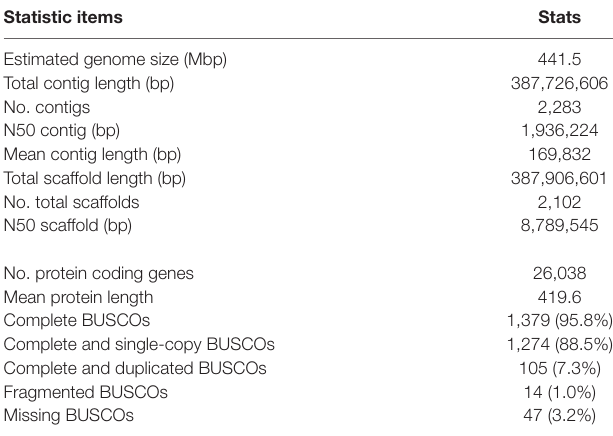
TABLe 3 | Stats of the assembled genome sequence of V. stipulacea. Statistic items Estimated genome size